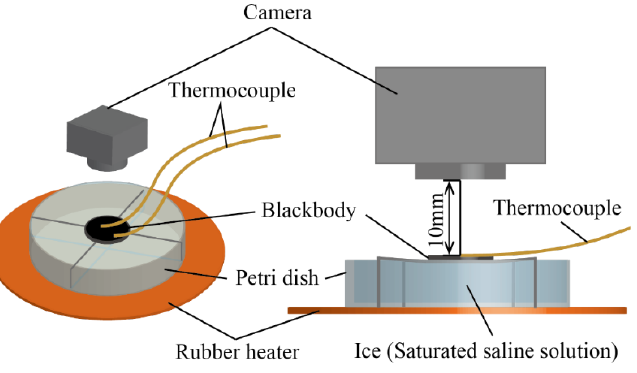
Figure 3. Experimental system used for far-infrared light camera calibration.